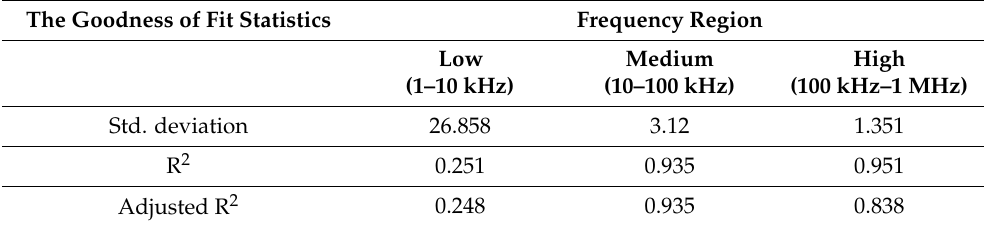
Table 8. Regression analysis for frequency regions at tap position 1.